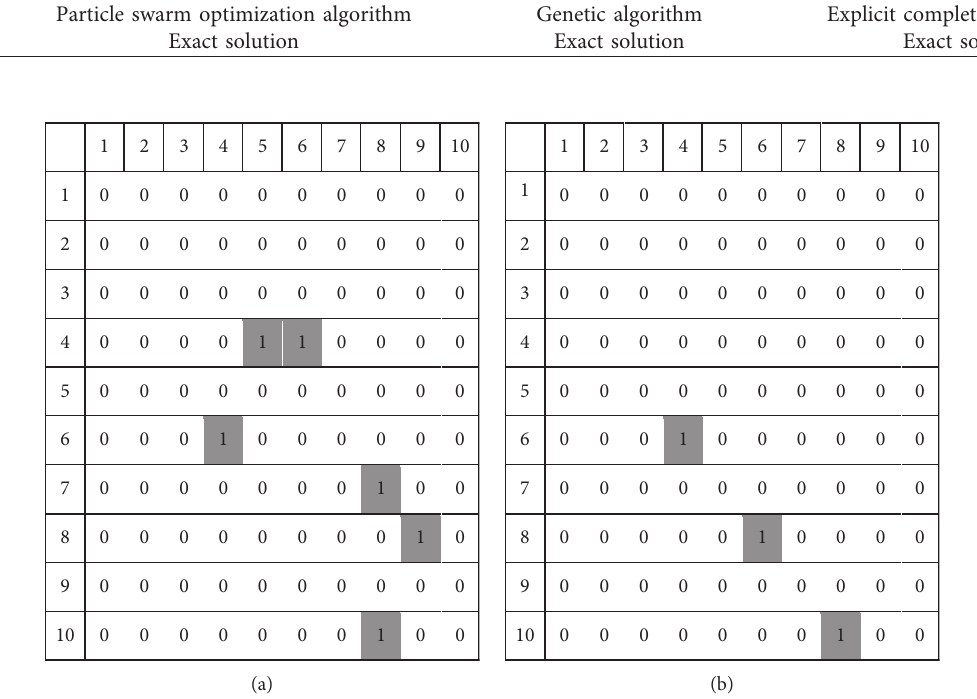
Figure 2: Solution representation for BHLRP. (a) An example of a network reserved lanes plan matrix with 10 nodes. (b) An example of a routing plan matrix for a task with 10